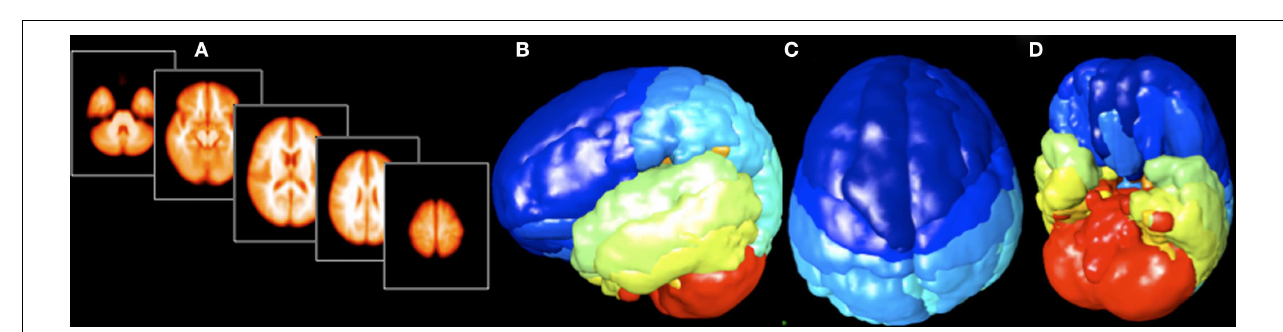
FIGURE 2 | Surface rendering of segmented sub-cortical structures labeled according to regions. (A) Examples of image slices along the axial view. (B–D) Parcellated cortical and sub-cortical regions along three views.